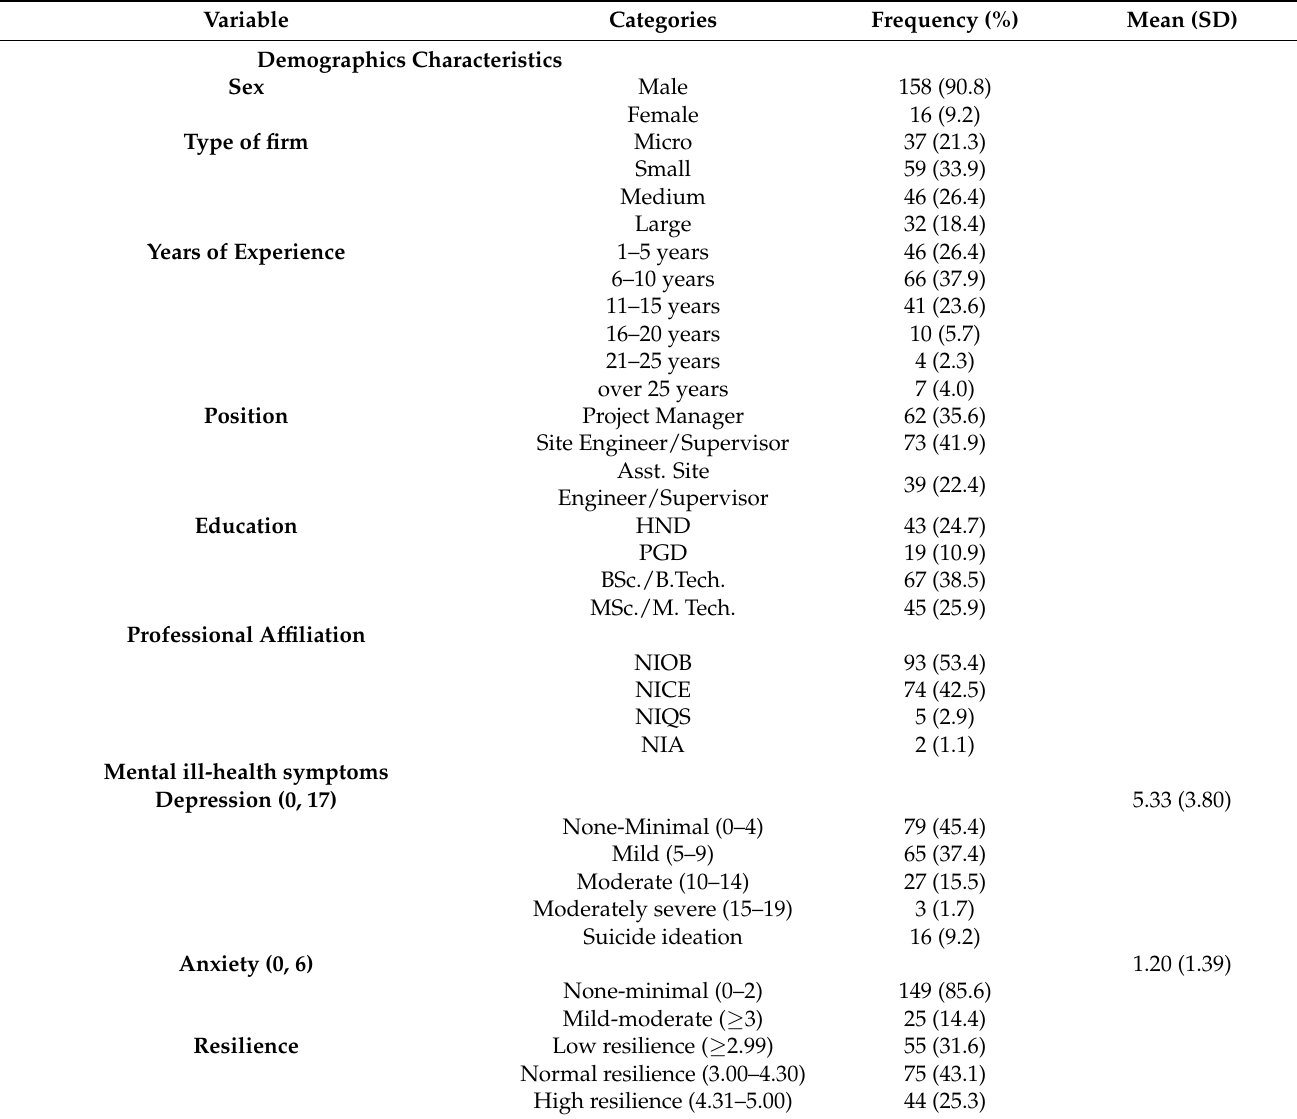
Table 1. Demographic, mental ill-health, and resilience characteristics of the